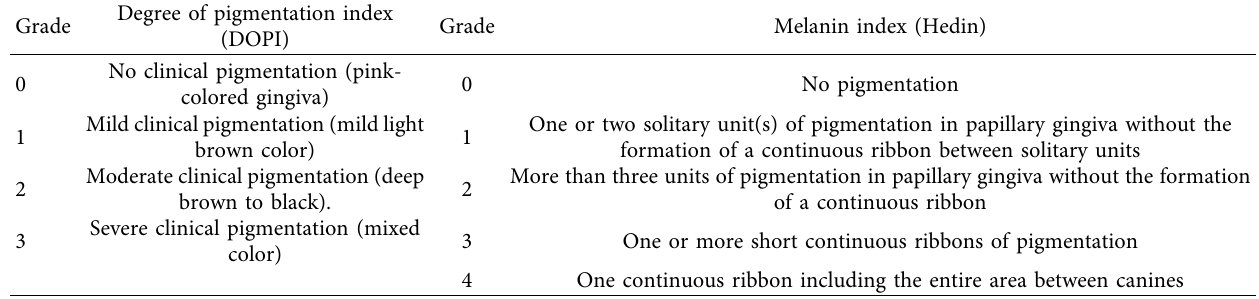
Table 2: Indices used for evaluation of the gingival pigmentation.